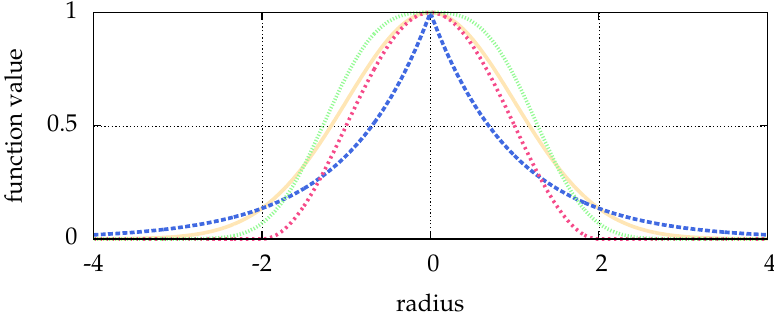
Figure 1. Shown are: the Hann function with N = 5 in pink ( (cid:4) ) , and the generalized Gaussian point spread function with p = 1 in blue ( (cid:4) ) , p = 3 in green ( (cid:4) ) and p = 2 in yellow ( (cid:4) ) . The latter is identical to the normal distribution. The width is σ = 1 for all cases. With different parameters p , the generalized Gaussian is able to mimic different particle shapes, which can e.g., result from defocused images.